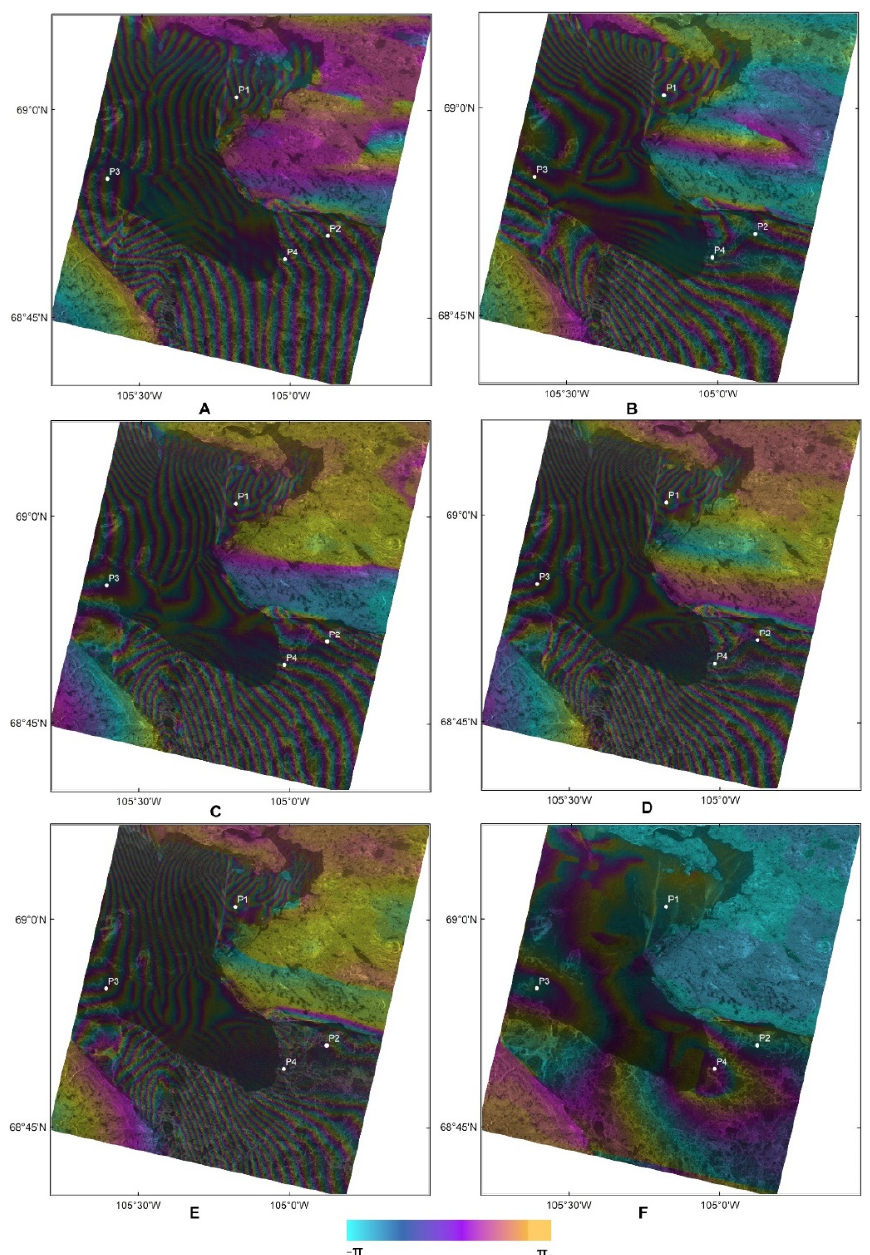
Figure 3. ALOS-2 interferograms from HH polarization ( A ): 17–31 January, ( B ): 17 January–14 February, ( C ): 17 January–28 February, ( D ): 17 January–28 March, ( E ): 17 January–11 April, ( F ): 28 March–11 April. One cycle of color ( −π to π ) representing 12 cm in range change.